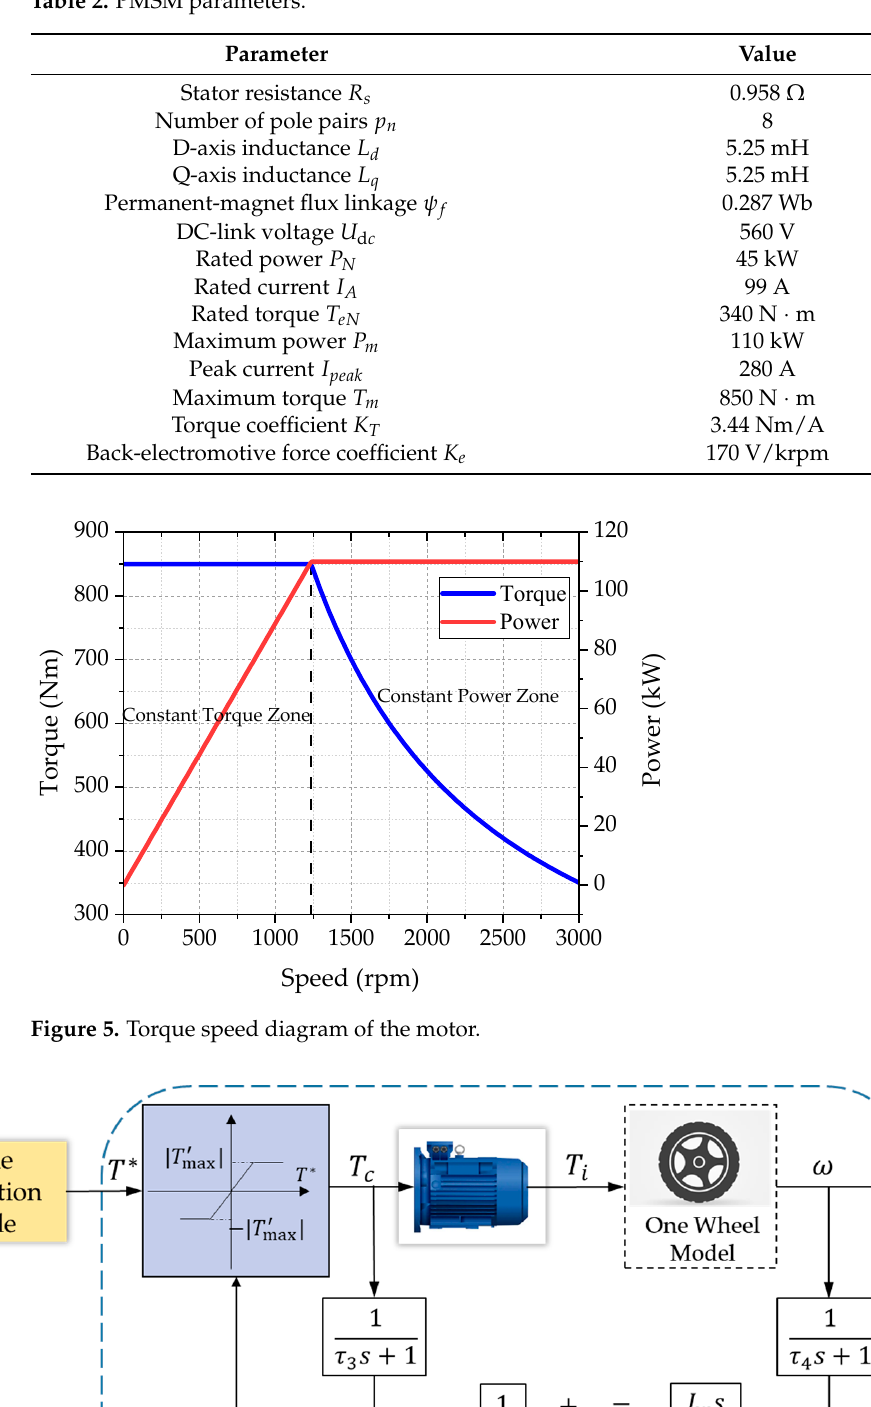
Figure 6. Control system based on MTTE. 4.1. Straight Line Under straight line driving conditions, the vehicle drives on a jointed road. The jointed road has a coefficient of adhesion of 0.8 from 0 to 20 m, which changes to 0.2 for